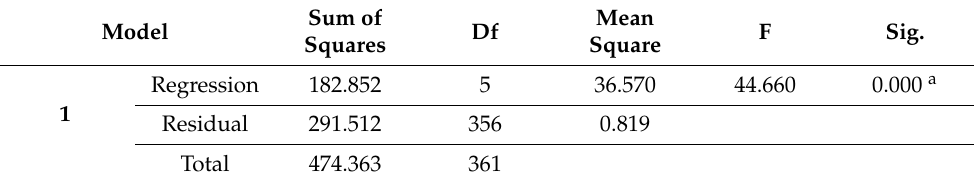
Table 8. Regression 2: ANOVA b